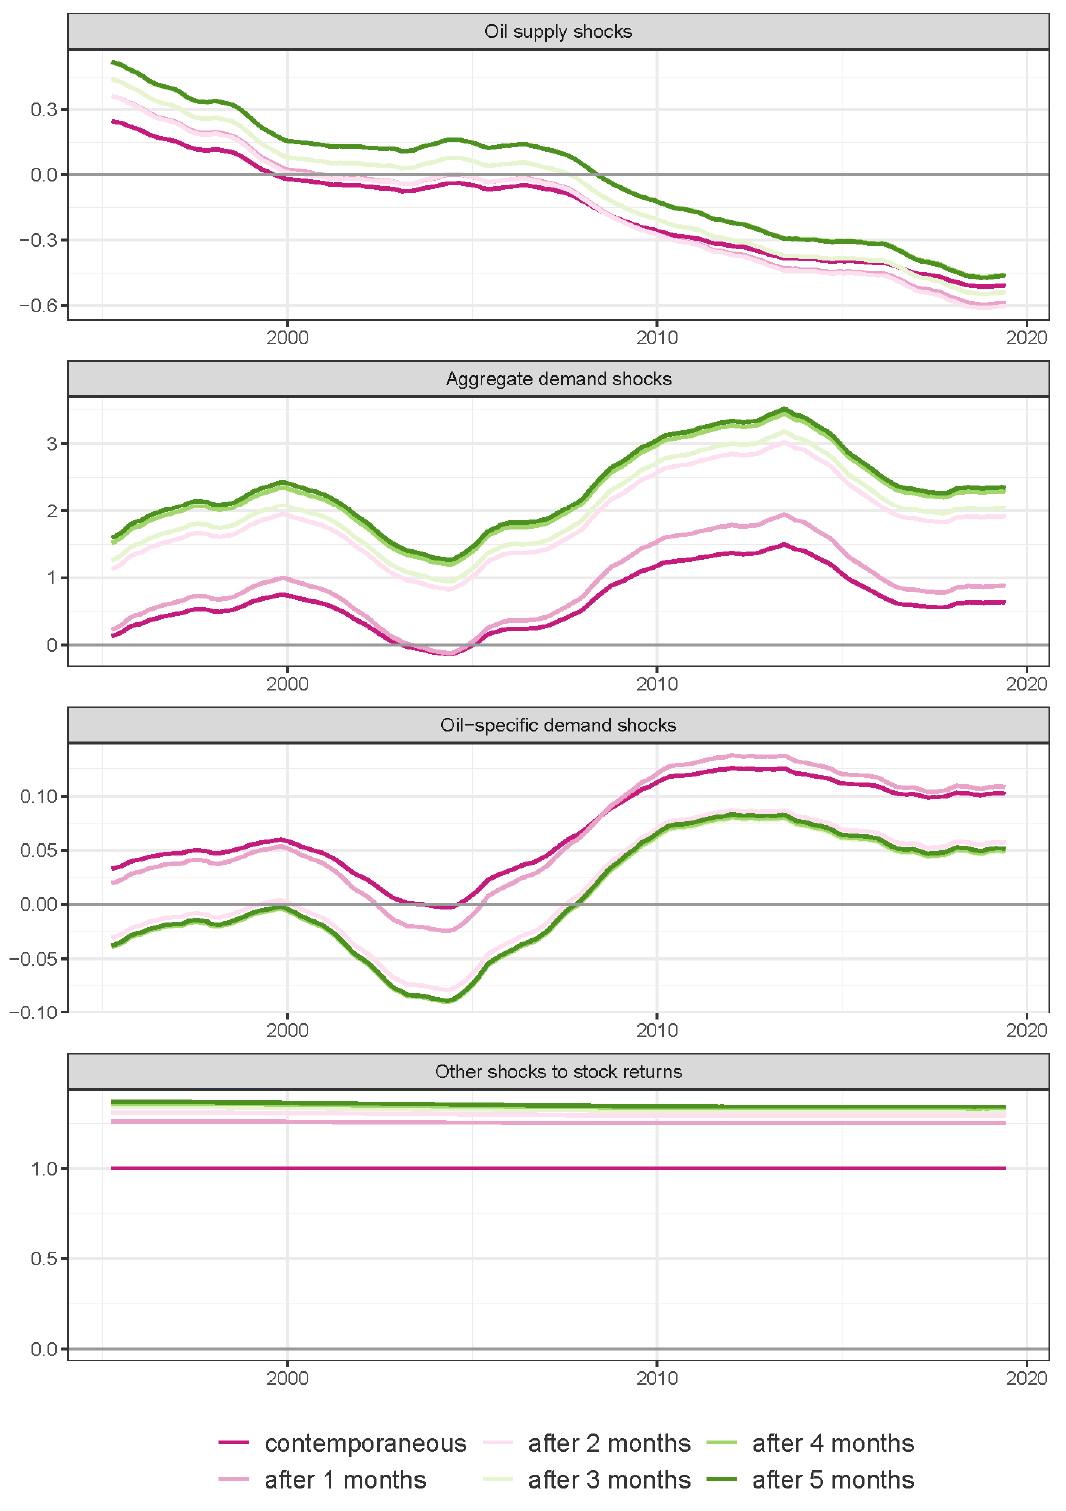
Figure A5. Responses of stock returns to structural shocks at different horizons. Note: This figure presents the accumulated responses of stock returns to a one-unit shock for each structural shock, both contemporaneously and after the first five months (1995:04–2019:06).